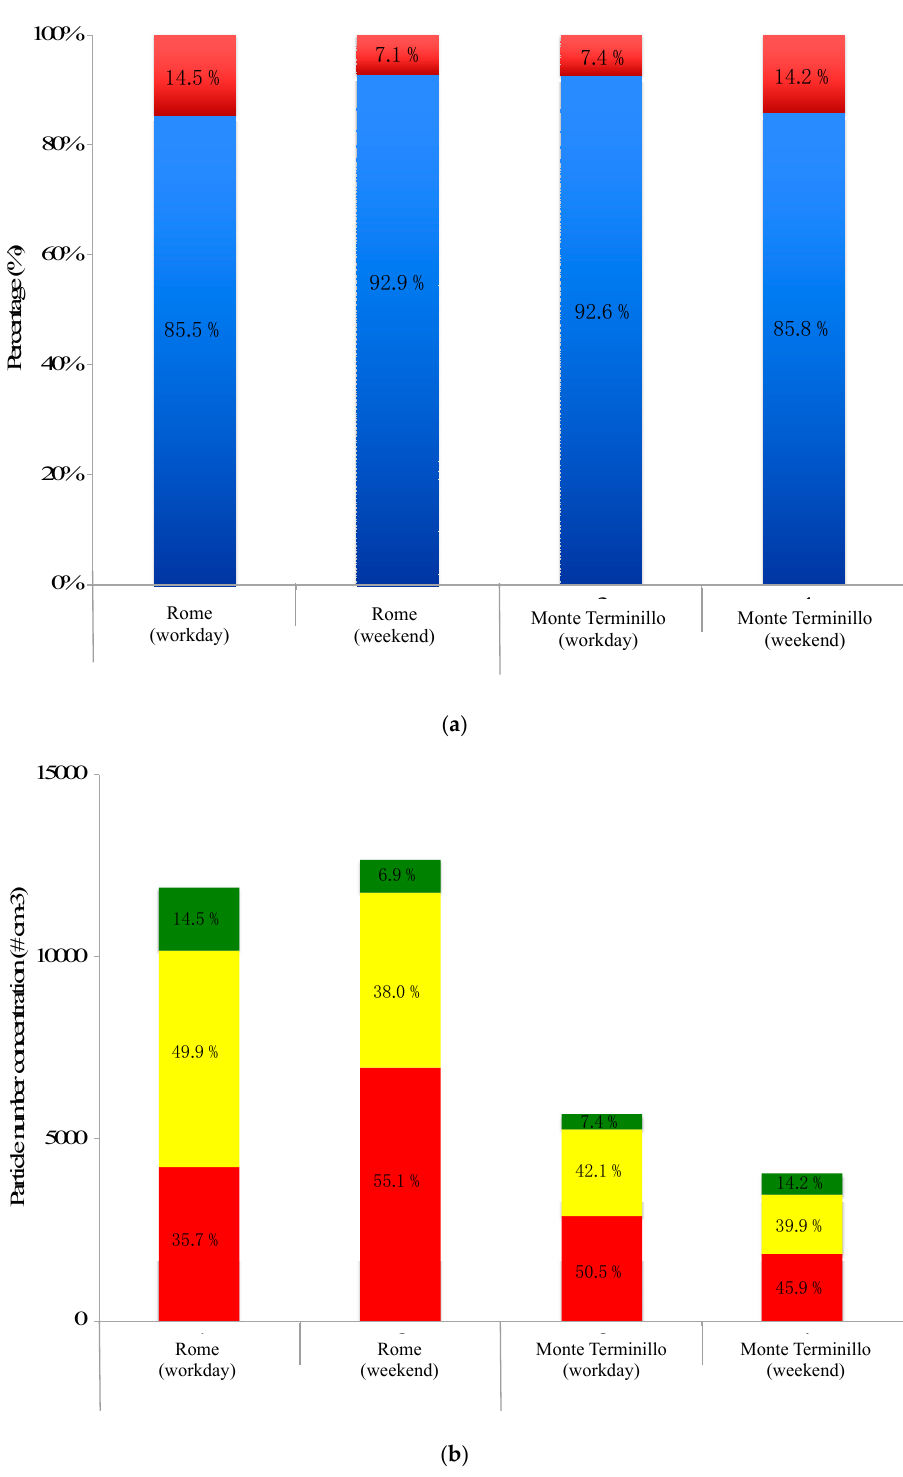
Figure 6. ( a ) UFPs and non-UFPs percentage ratio in the two sites during workdays and weekends; ( b ) particle number concentrations and average percentages of the submicron aerosol subdivided in three modes, i.e., nucleation mode (red bars), Aitken nuclei mode (yellow bars), and accumulation mode (green bars), in the two sites investigated.